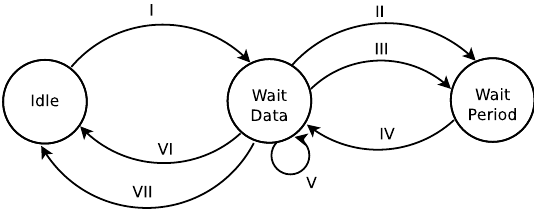
Figure 1. Finite State Machine for the Client/Requester. Table 1. Description of the Client